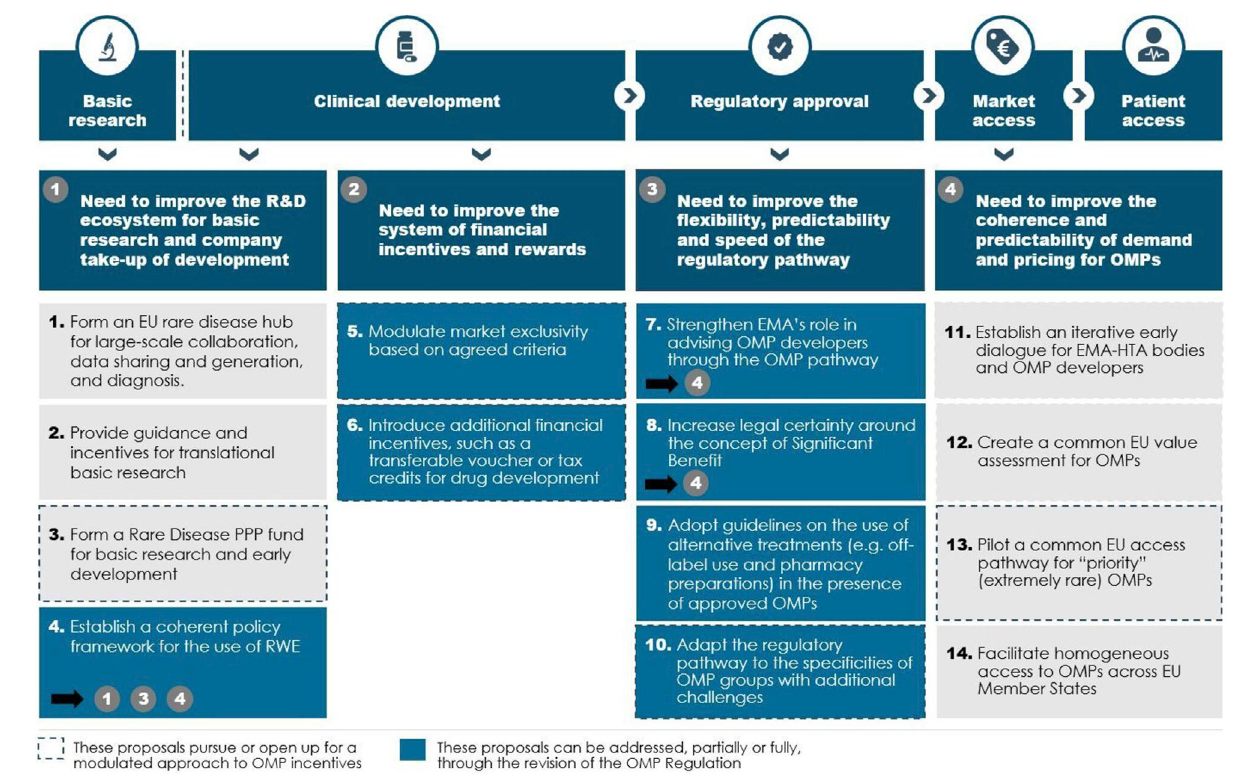
Frontiers in Pharmacology |